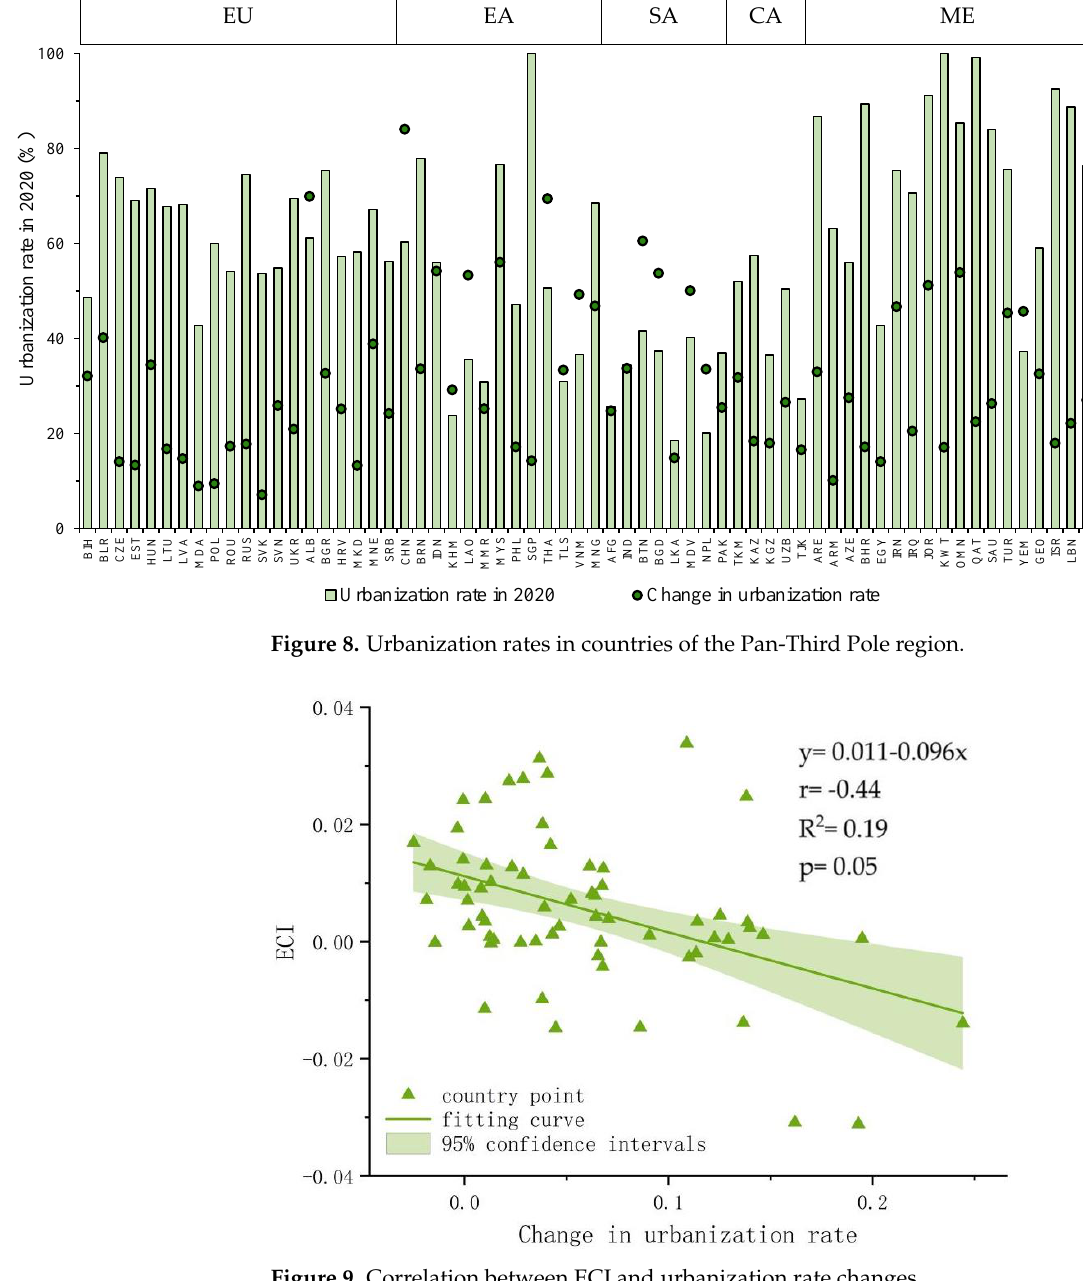
Figure 9. Correlation between ECI and urbanization rate changes.